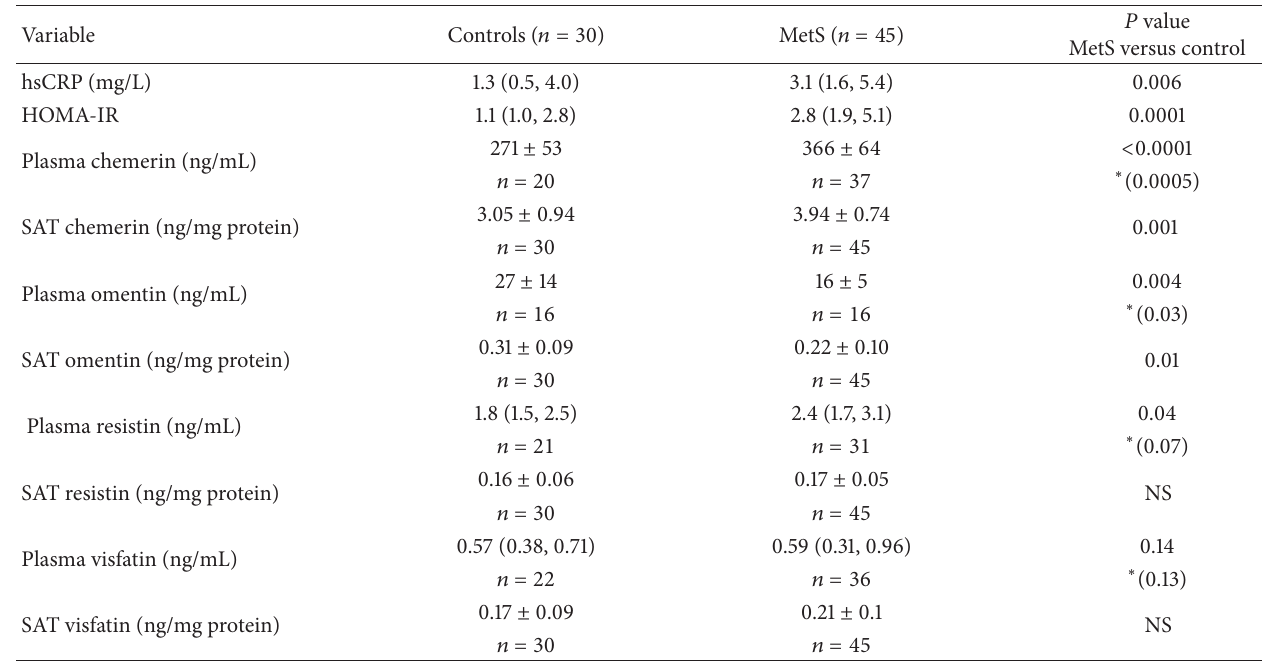
Table 2: Novel adipokine